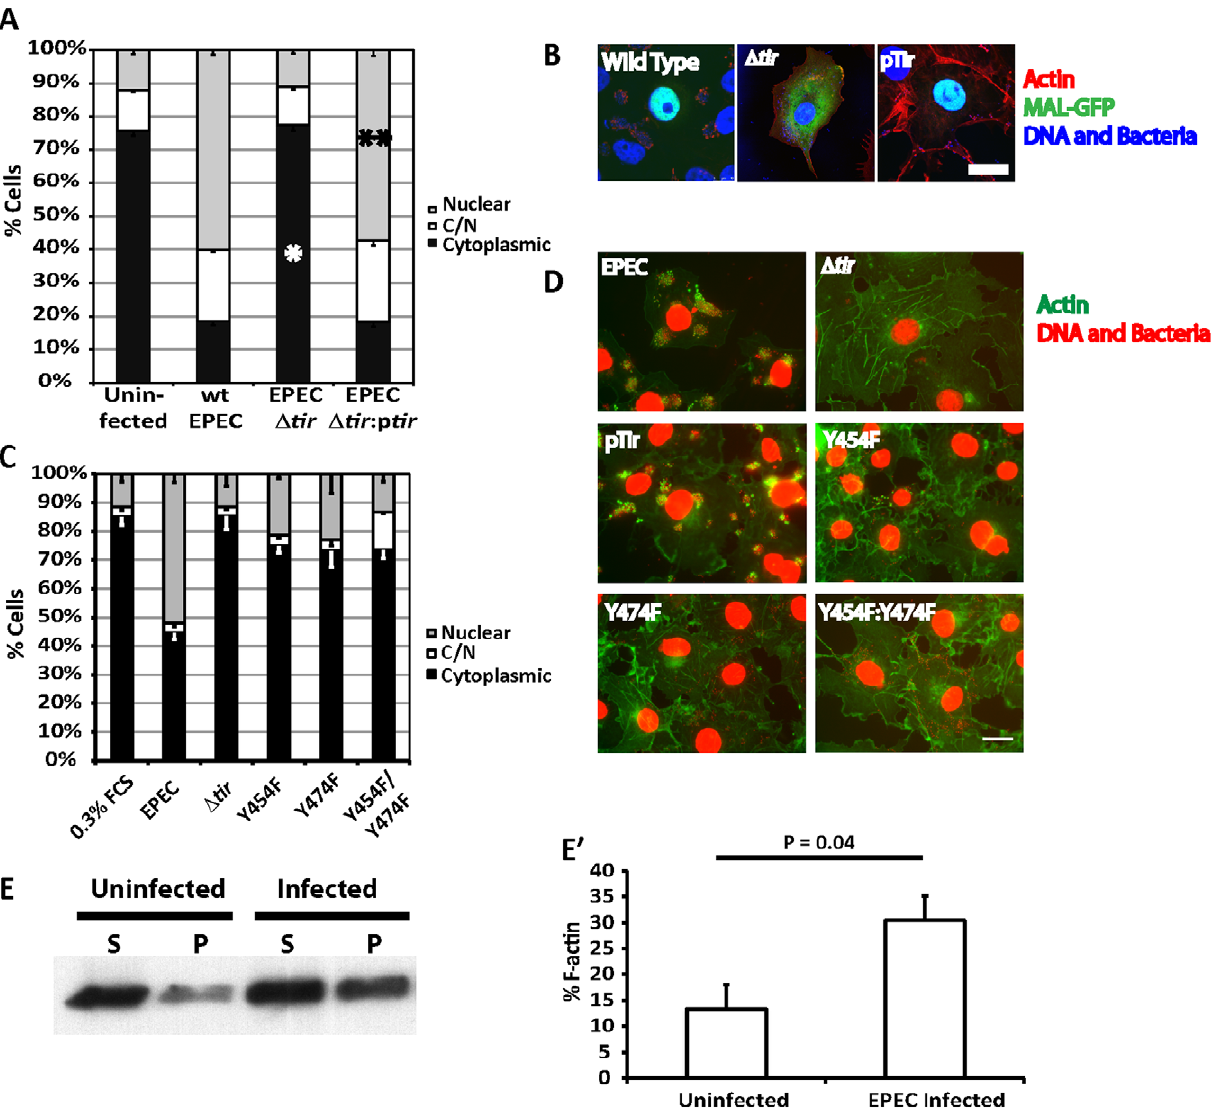
Figure 4. Tir is essential for EPEC induced MAL-GFP translocation. A. EPEC D tir cannot induce the nuclear translocation of MAL-GFP. COS-7 cells were transfected with MAL-GFP, serum starved then infected with the indicated bacteria. The percentage of transfected cells that had MAL-GFP